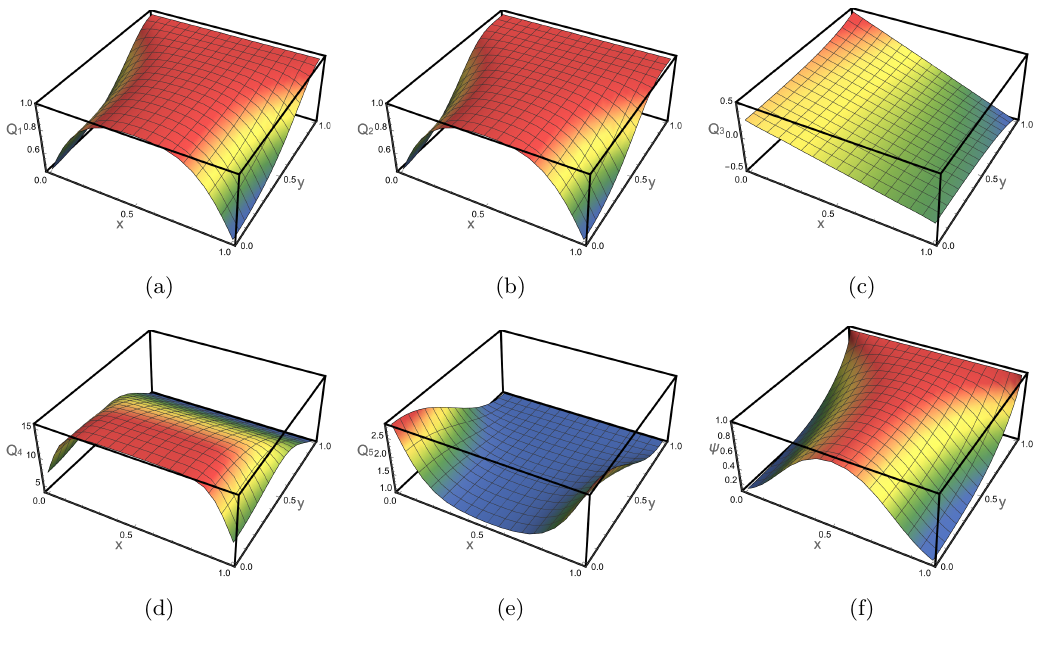
Figure 3 . Free parameters are fixed to be { θ 1 , θ 2 , w 0 , µ, L } = { π/ 4 , π/ 4 , 2 , 1 , 1 } , while { Q 1 , Q 2 , Q 3 , Q 4 , Q 5 , Q 6 } as functions of ( x, y ) are shown from (a) to (f).